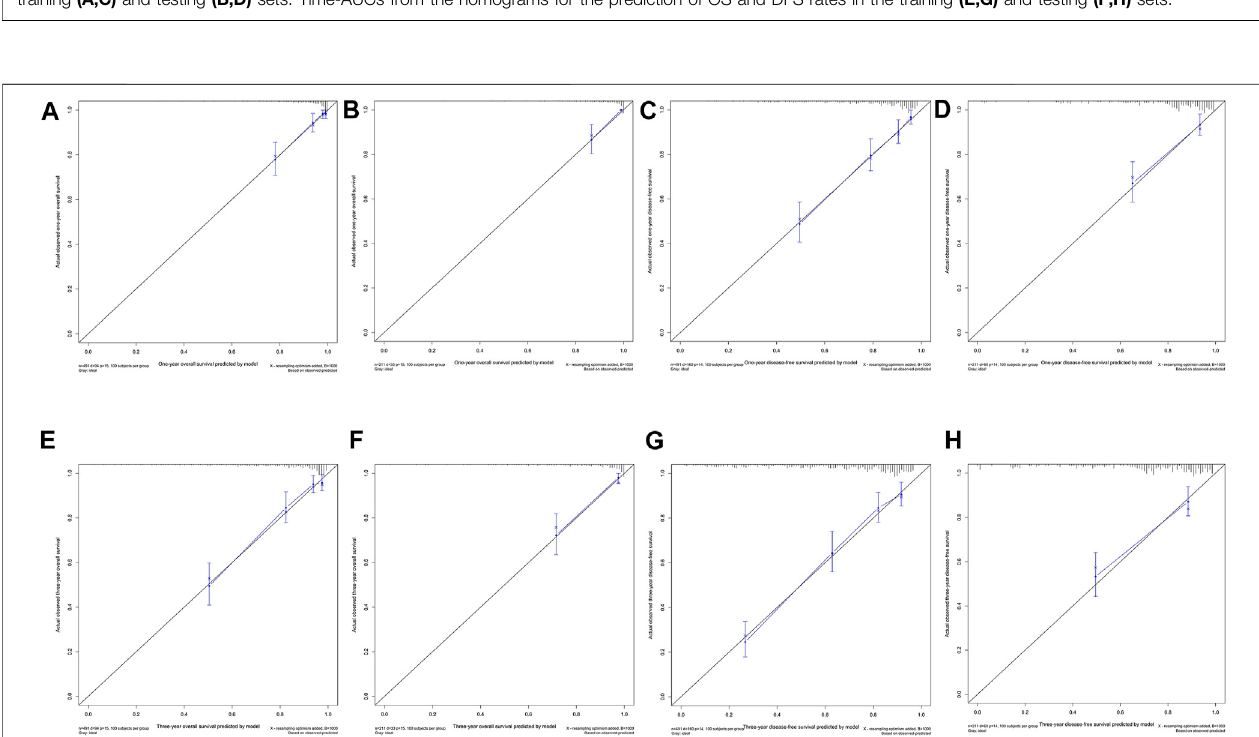
FIGURE 3 | One-year and 3-year calibration curves of the model. One-year calibration curves from the nomograms for the prediction of OS and DFS rates in the training (A,C) andtesting (B,D) sets.Three-yearcalibrationcurvesfromthenomogramsforthepredictionofOSandDFSratesinthetraining (E,G) andtesting (F,H) sets.